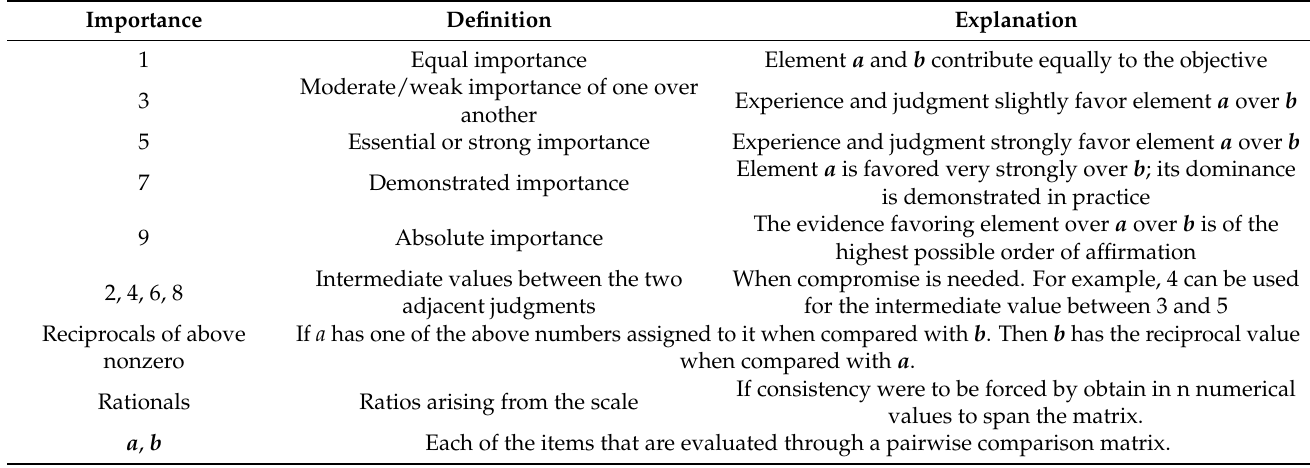
Table 3. The Fundamental Scale for Pairwise